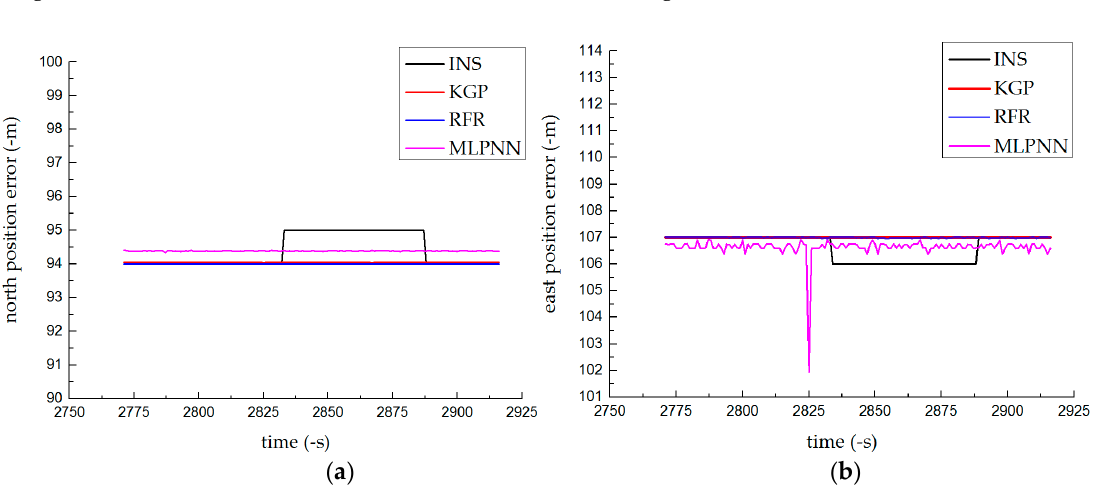
Figure 6. Prediction results of the parking test: ( a ) north position error and ( b ) east position error.